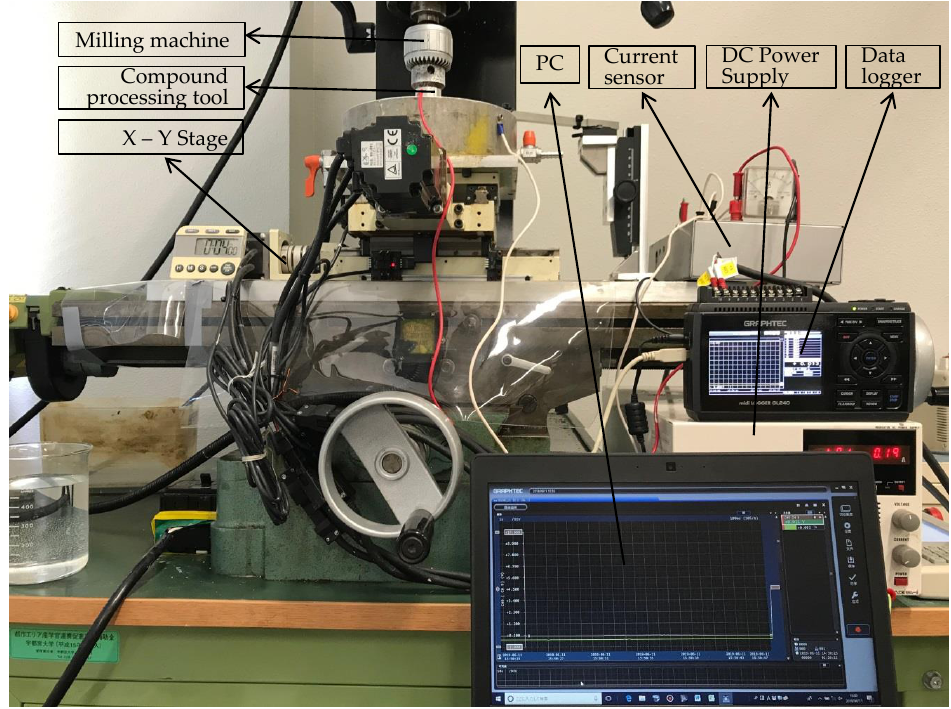
Figure 3. External view of experimental setup.